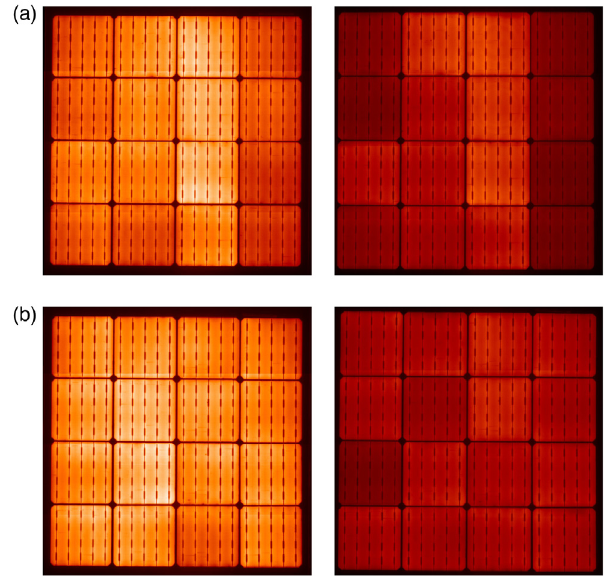
Fig. 14. Electroluminescent test results after 300 thermal cycles for two out of the six modules that underwent TC tests. (a) Electroluminescent test results at initial time (left) and after 300 TC (right) for the worst module manufactured with Cooling Press. (b) Electroluminescent test results at initial time (left) and after 300 TC (right) for the worst module manufactured without Cooling